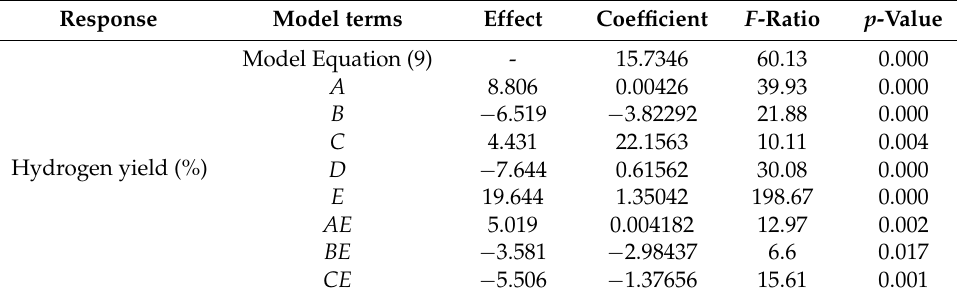
Table 6. The regression coefficient value of the reduced model for Y 2 .